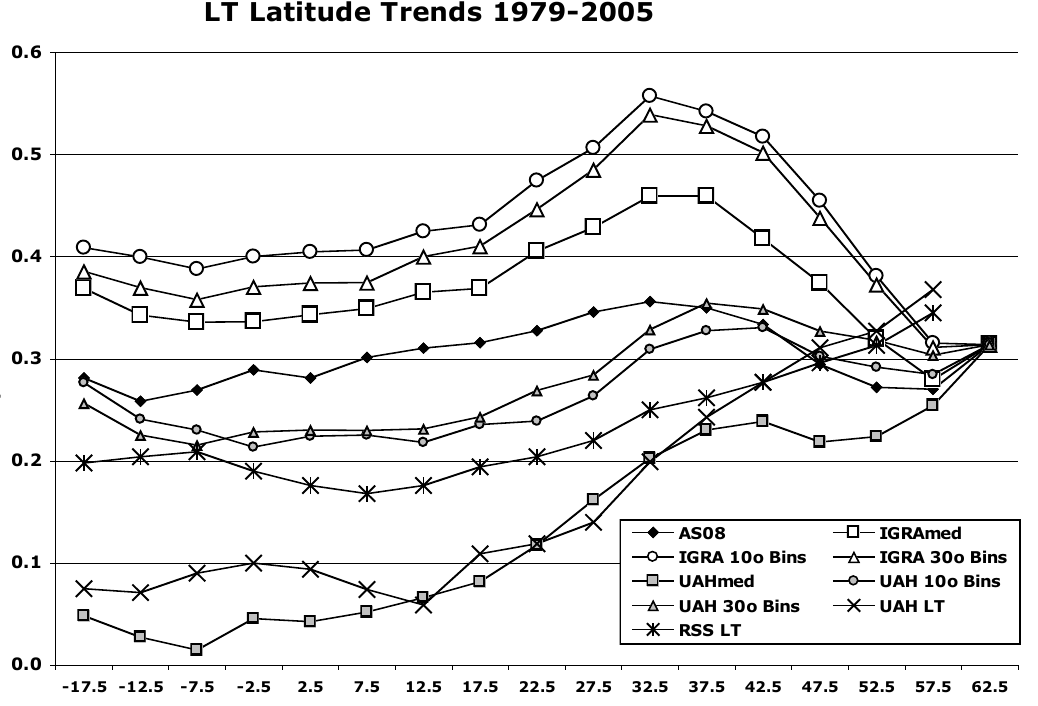
Figure 9. As in Figure 8 except the trend values are tied to 32.5°N as the starting integration point (and integrating in both directions for TWE